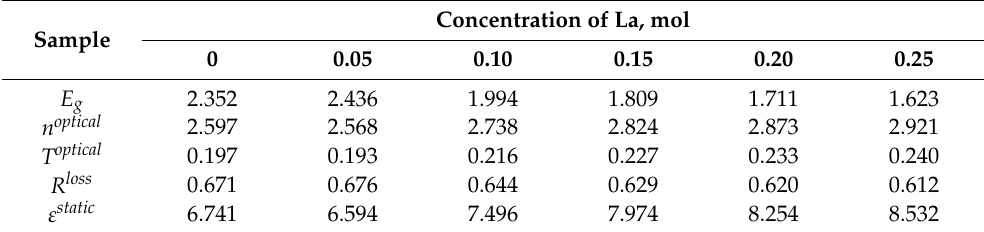
Table 3. Data of optical